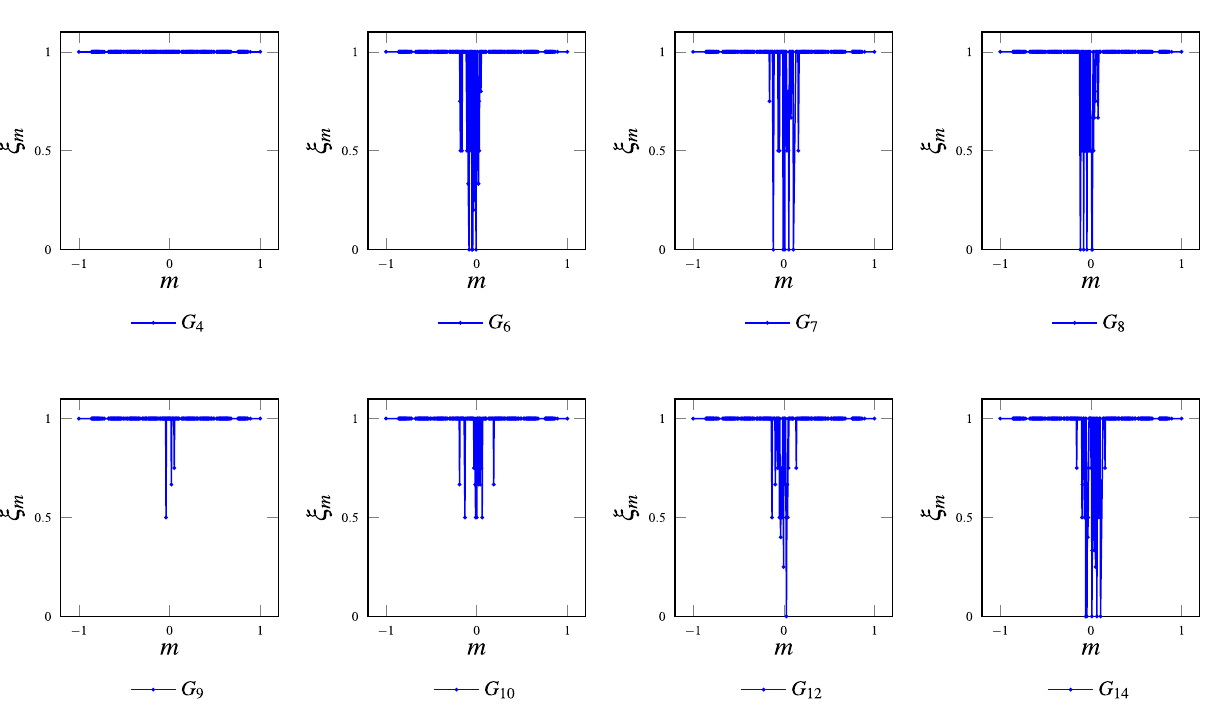
Figure 10. Non-perfect consensus efficacy: grids G 4 , G 6 , G 7 , G 8 , G 9 , G 10 , G 12 and G 14 ; 21 × 21 Toruses, Periodic Boundary Conditions and Asynchronous Update. Grid G 4 has a special condition because the pattern of its spurious fixed point (chessboard) cannot be obtained from an odd number of nodes (as in a 21 × 21